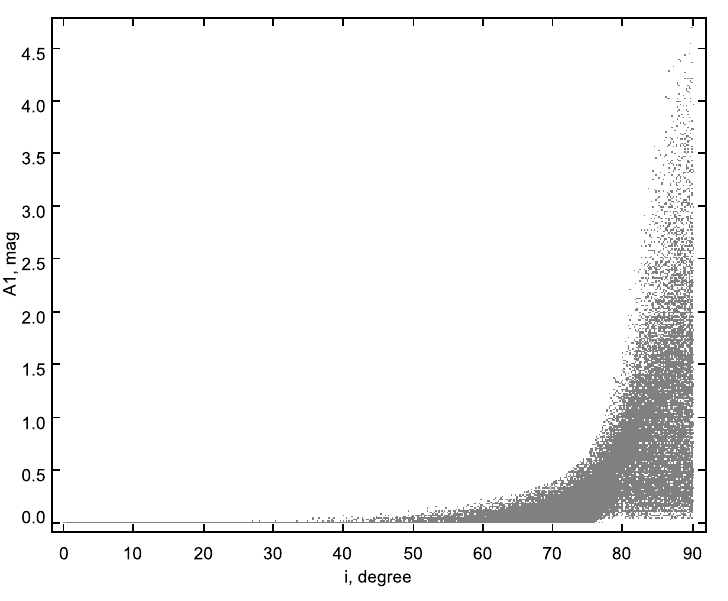
Fig. 1. Depth of primary minimum vs. orbital inclination for simulated binaries.